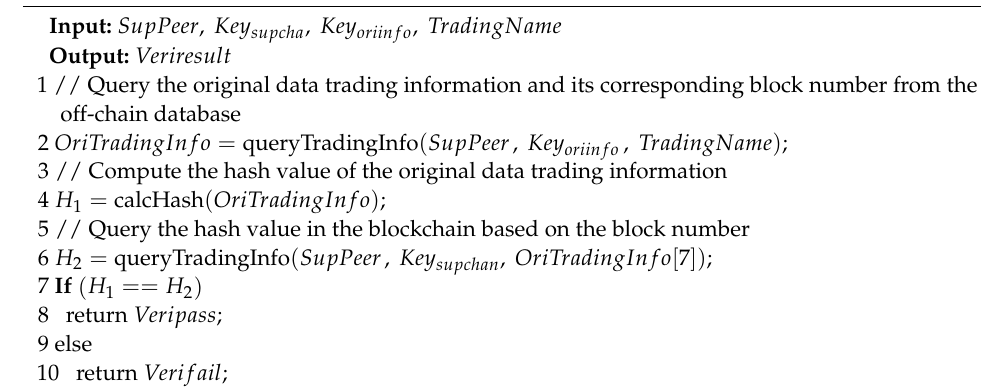
Algorithm 3: Verification algorithm of data trading information traceability process